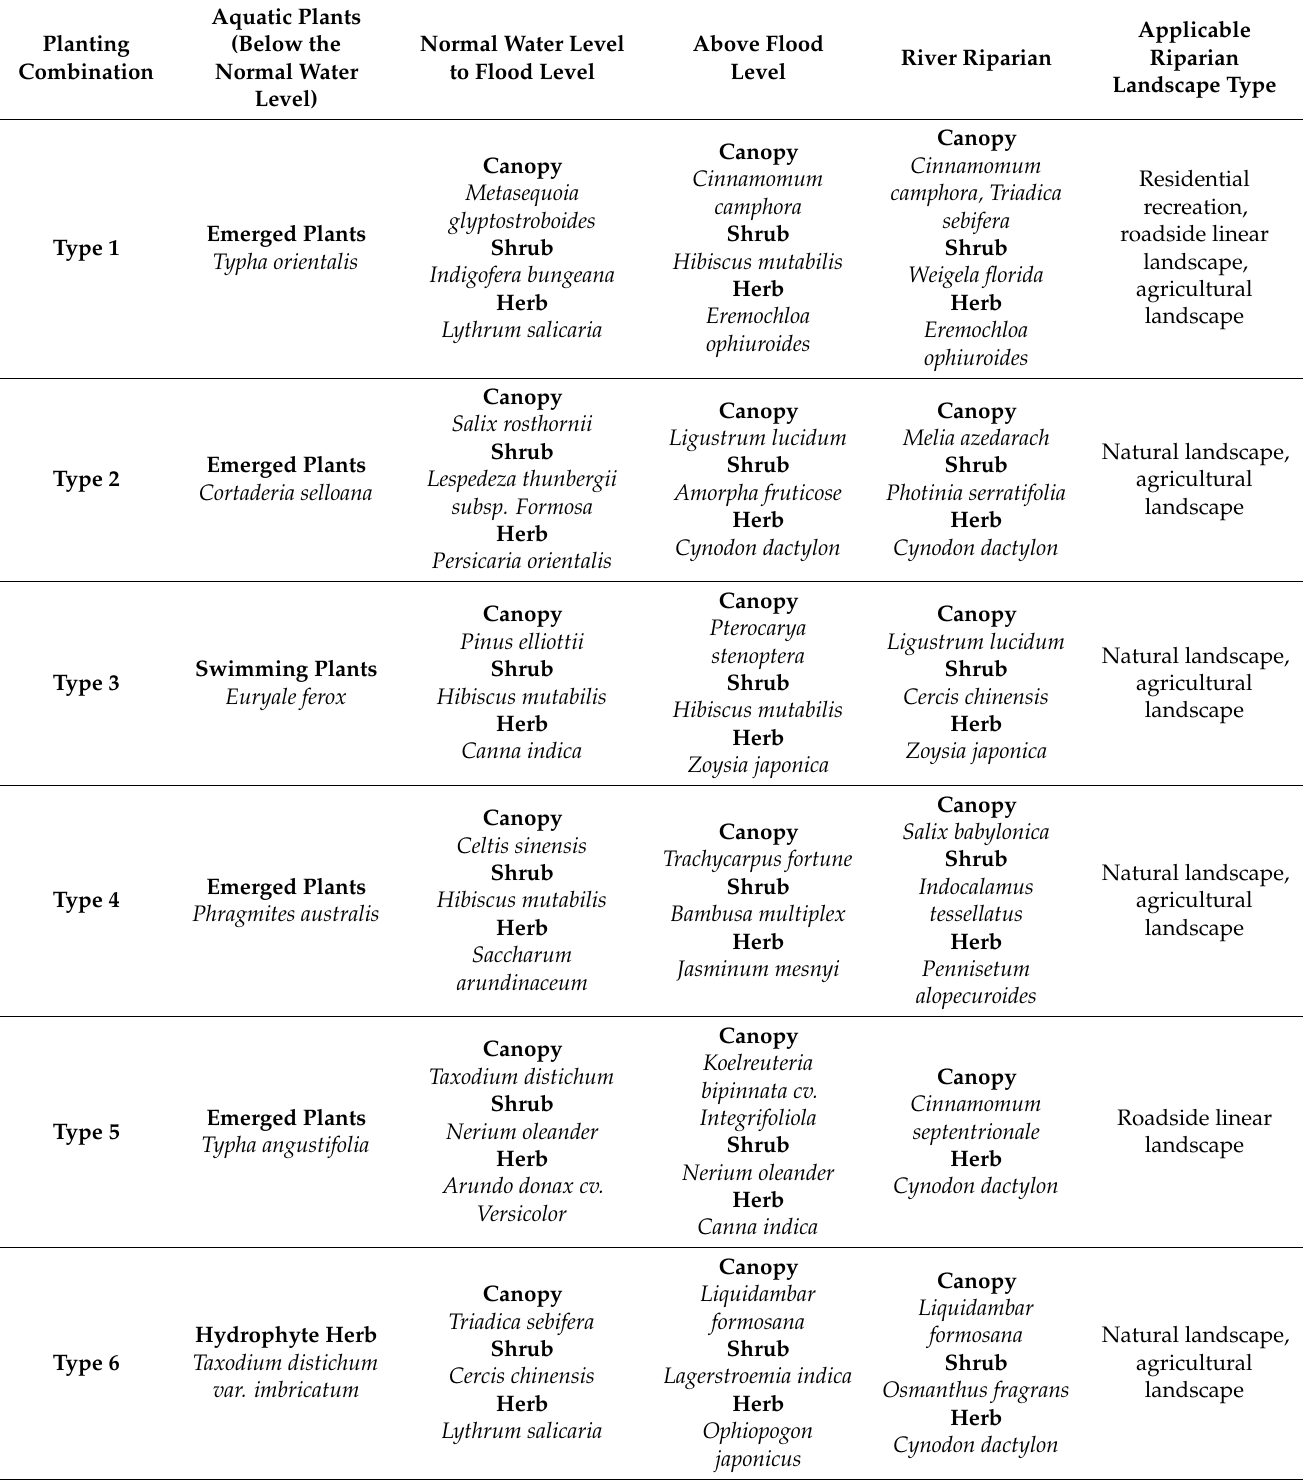
Table 10. Recommended plant combination list (source: